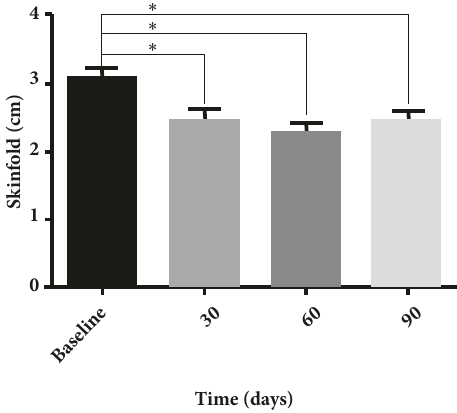
Figure 4: Means, with a standard error of the mean, of the abdominal length skinfold before treatment (baseline) and after treatment (30, 60, and 90 days after treatment). ∗ P <